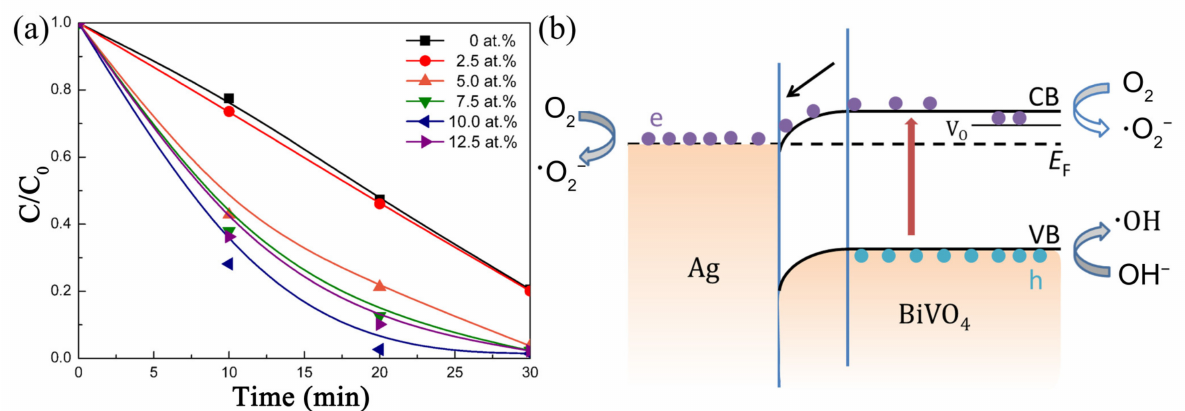
Figure 9. ( a ) The photocatalytic performance of Ag-BiVO 4 nanofibers under visible light irradiation; ( b ) the proposed mechanism. (Redrawn with the permission of Ref. [64]. Copyright 2018 Science